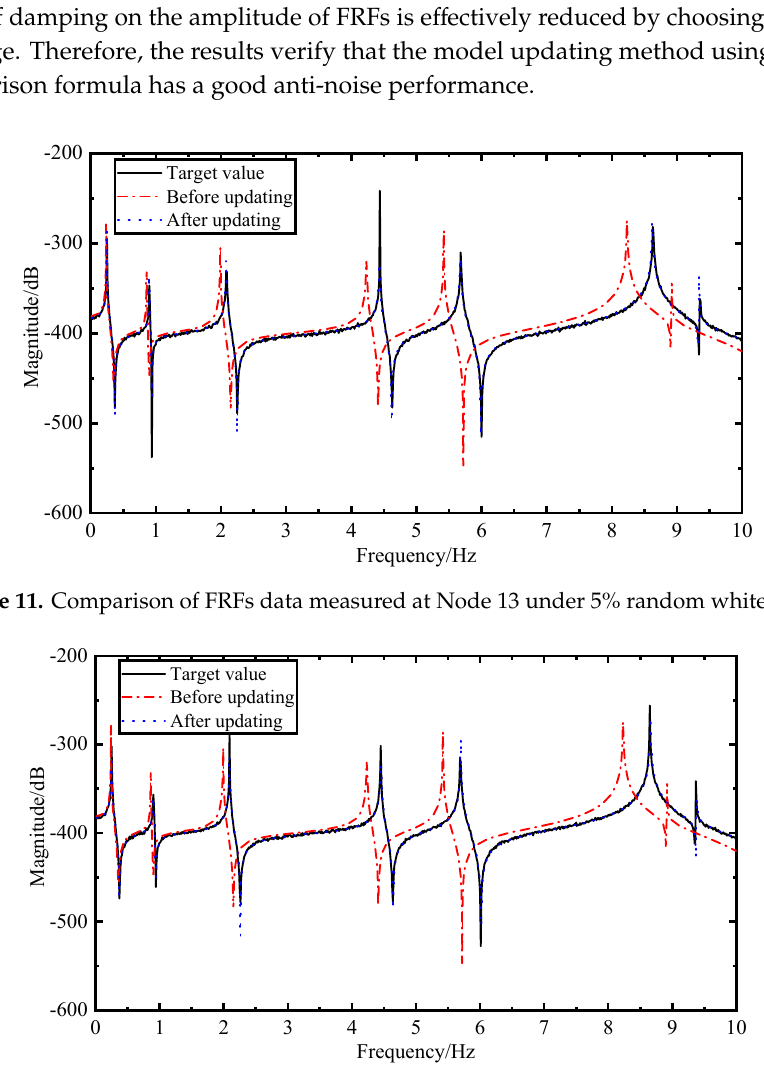
Frequency/Hz Target value Before updating Selected frequency range Figure 10. Selected frequency range. Where Error b and Error a is the relative error between the frequency values of the FE model before and after the updating and the target value, respectively. As can be seen from Table 5, under the excitation of 10% random white noise, the maximum relative error of the frequency is changed from − 5.49% to − 1.10%, which verifies the effectiveness and anti-noise performance of the proposed method in this paper.